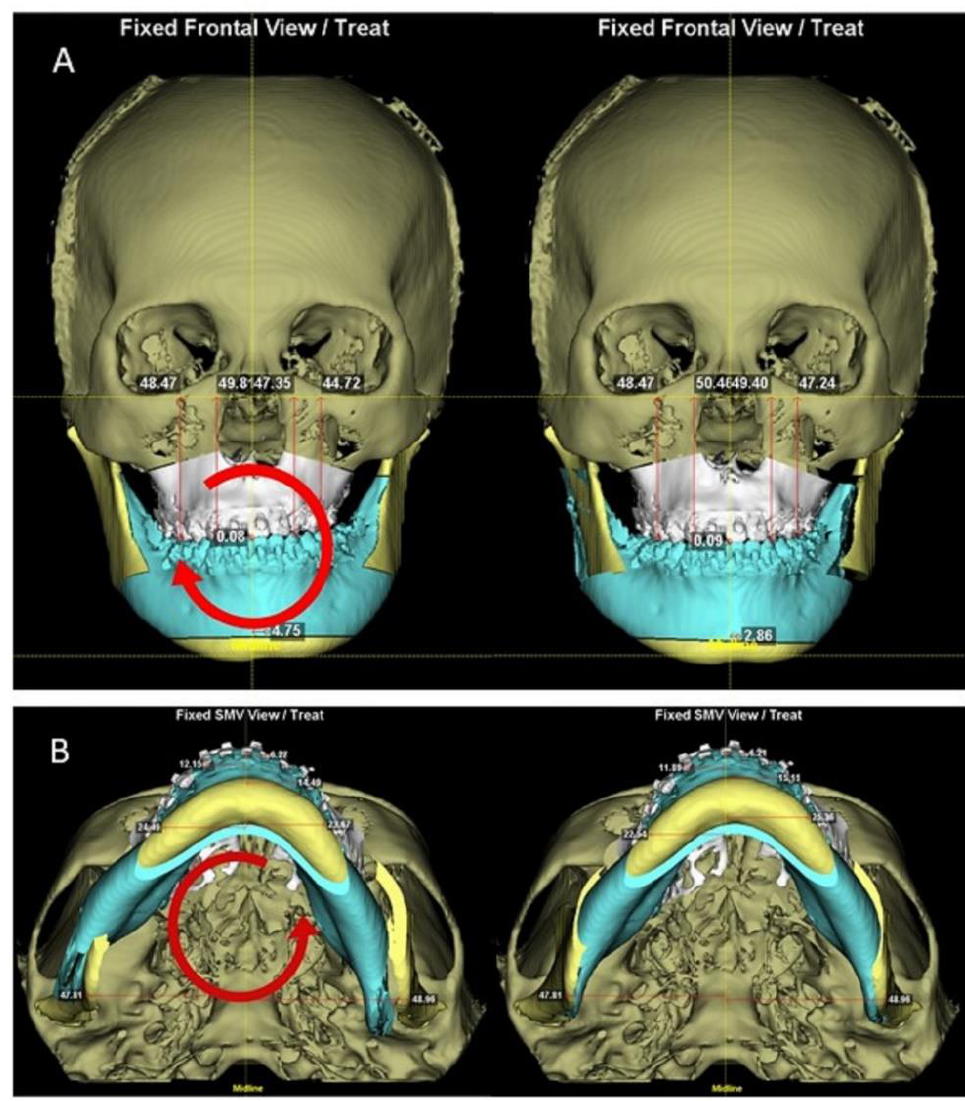
Figure 4. The same case as in Figure 1 demonstrated roll and yaw rotations of the maxillomandibular complex for asymmetry correction in two-jaw surgical planning. ( A ) Occlusal plane and chin deviation were improved after clockwise rotation in the roll direction. ( B ) Elimination of residual asymmetry of contour and interference between the osteotomized bony segments by counterclockwise rotation of the maxillomandibular complex in the yaw direction. As a result, the advancement in the LeFort I level was 1.50 mm in the right piriform and 5.07 mm in the left piriform.